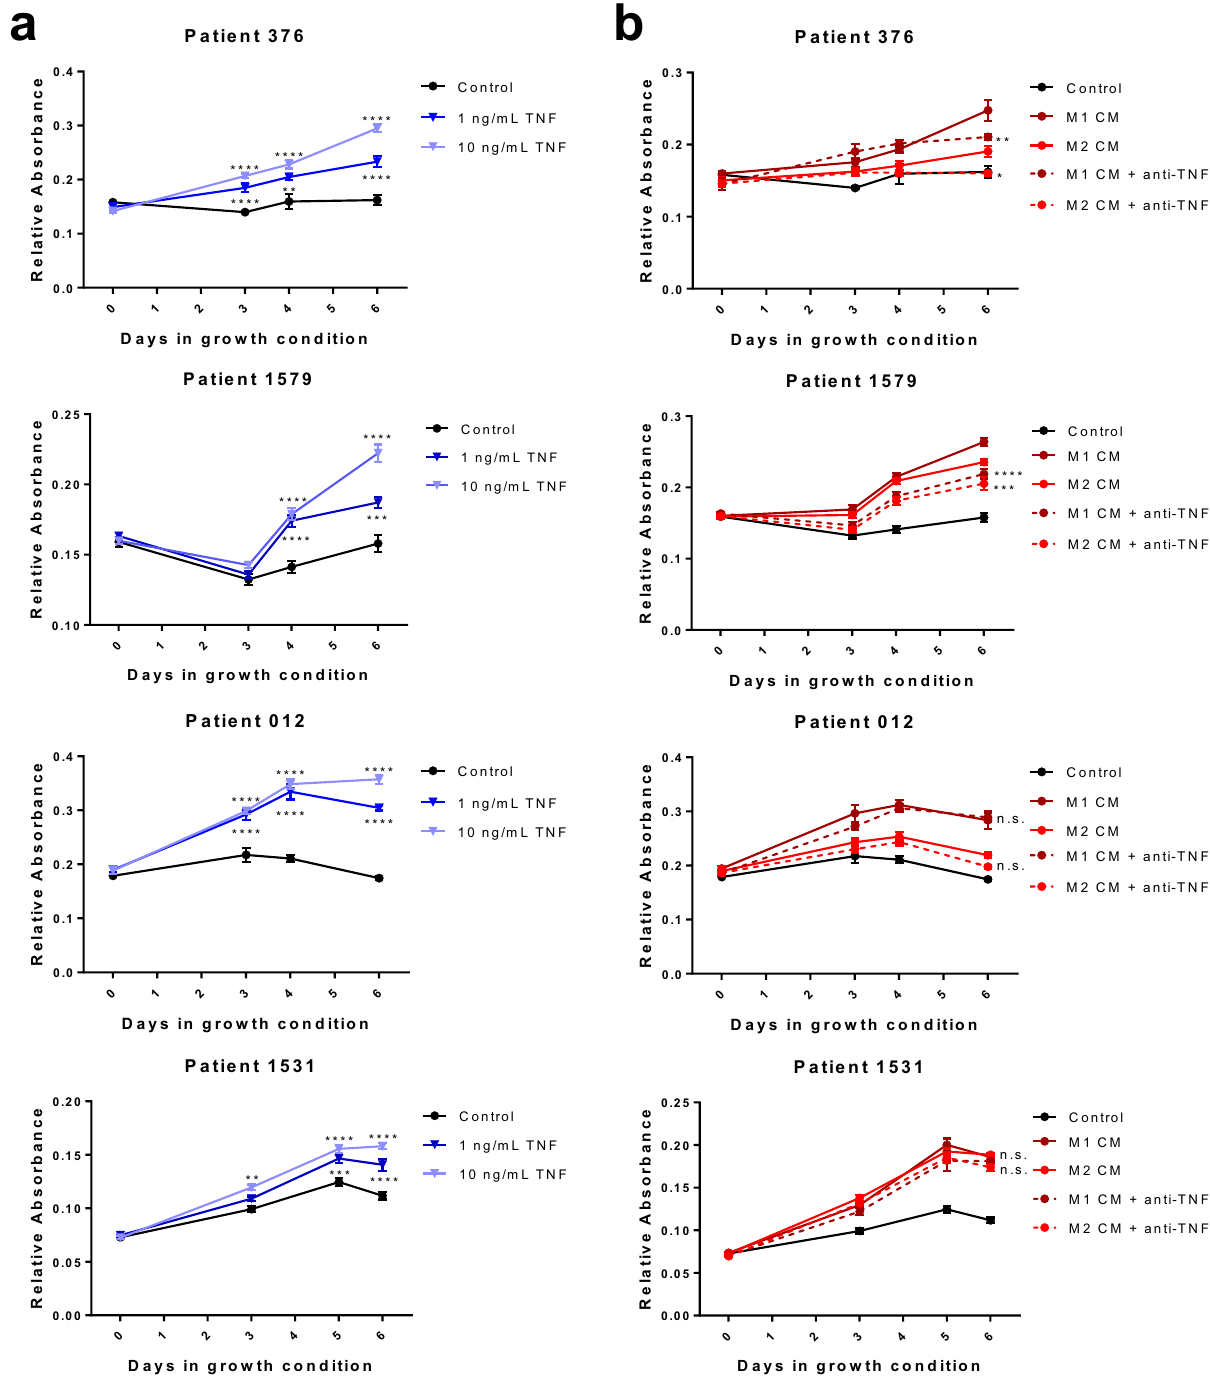
Fig. 6 Macrophage-derived TNF promotes prostate fi broblast cell growth. Primary prostate fi broblasts from two BPH tissues (patients 376, 1579, 012, and 1531) were subjected to indicated treatments. Crystal violet growth assays were performed in low serum conditions (0.5%) over six days. a Fibroblast cultures ( n = 4 independent patients) were grown in the presence or absence of 1 or 10 ng/mL recombinant TNF (dark and light blue, respectively). Asterisks indicate signi fi cant differences compared to control samples (black lines), determined by two-sided, two-way ANOVA with multiple comparisons test. b Fibroblast cultures ( n = 4 independent patients) were grown in the presence of 50% M1 (dark red) or M2 (light red) macrophage conditioned medium (generated from THP-1 cells) ±40 µ g/mL TNF neutralizing antibody. Conditions containing anti-TNF neutralizing antibody are indicated with dashed lines. Points indicate the mean ± SEM of at least fi ve technical replicates and graphs are representative of three independent experiments. Asterisks indicate signi fi cant differences compared to the paired conditioned medium condition without anti-TNF neutralization, using a two-sided, two-way ANOVA with Tukey ’ s multiple comparisons test. Source data are provided as a Source Data fi le. n.s. = not signi fi cant, * p < 0.05, ** p < 0.01, *** p < 0.001, and **** p <